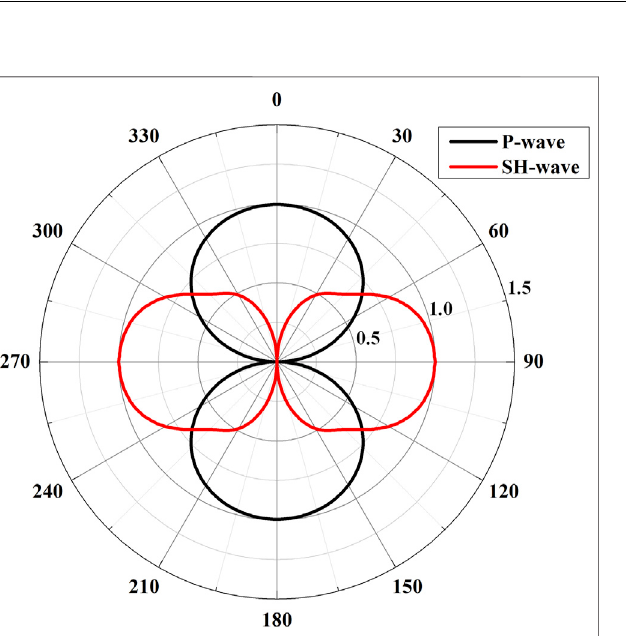
representing three orthogonal directions as shown in Figure 6 . The centers of these circles are at the origin. The radiuses R of these circles are all 5.0 m. The red, blue and green circles are in xoy -, xoz -, and yoz -plane respectively. The small black spheres represent the receivers on the circles. The vibration velocities v r , v v θ and φ in spherical coordinate were derived from v x , v y and v z by coordinate transformation. According to the polarization direction of these waves, the v r , v θ and v φ in Spherical coordinate correspond to P-, SV- and SH-waves, respectively. Figure 7 shows the v r (P-wave) and v φ components (SH-wave) received